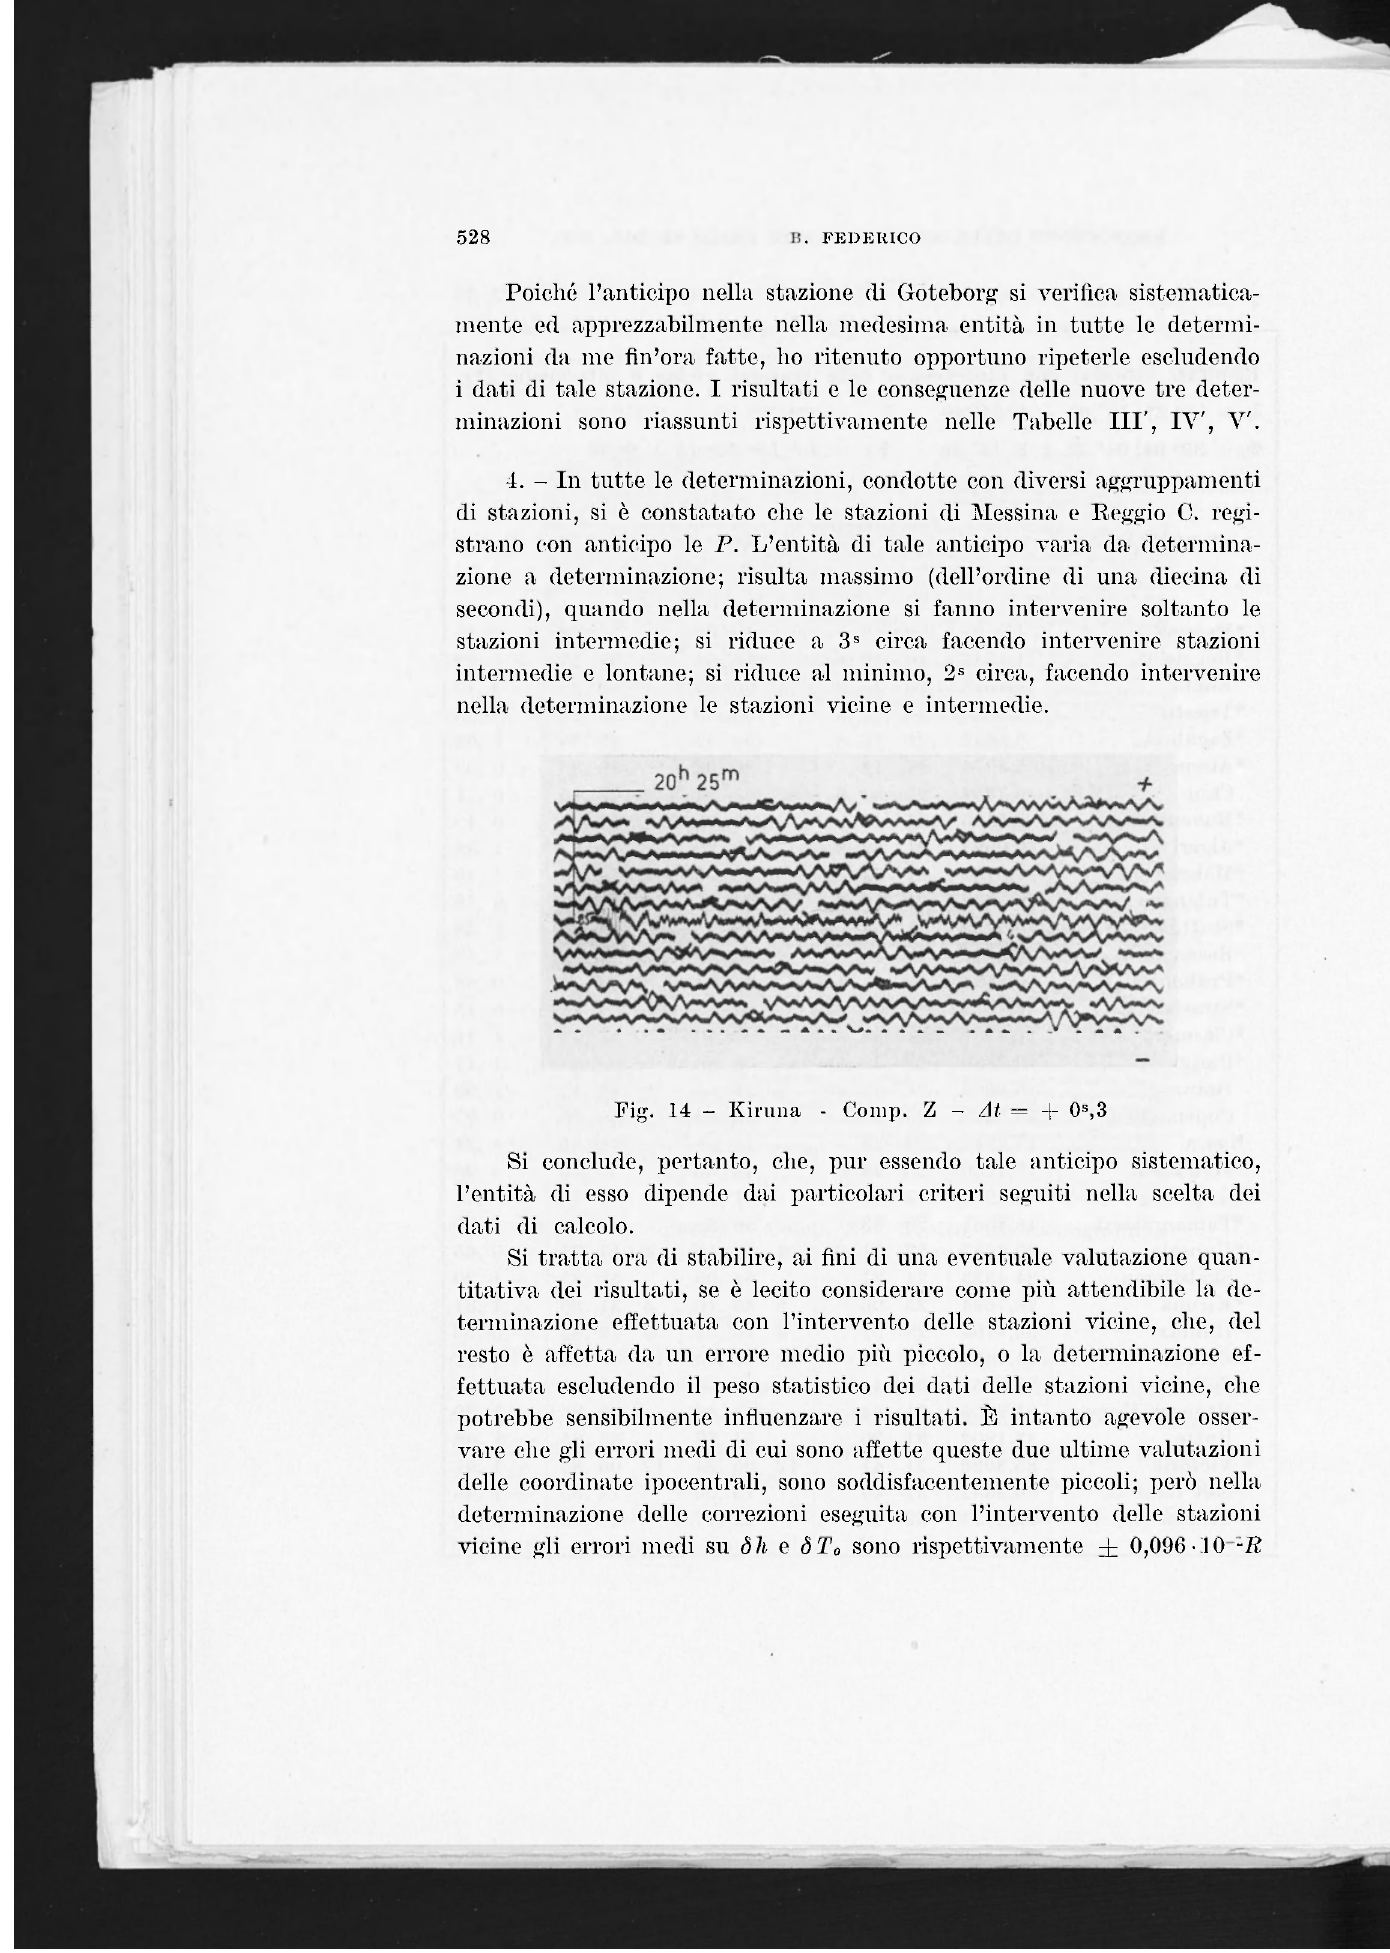
Fig. 14 - Kiruna - Comp. Z - At = + 0 S